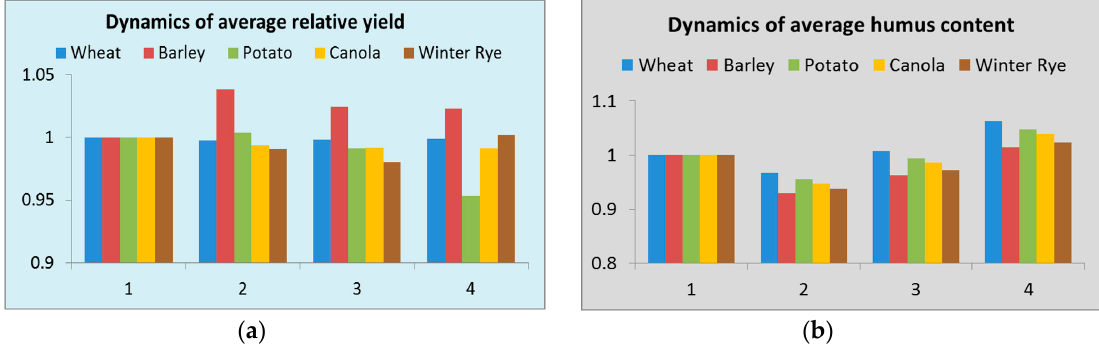
Figure 11. Results for full variant (all measures): ( a ) Dynamics of average relative yield; ( b ) Dynamics of average humus content.